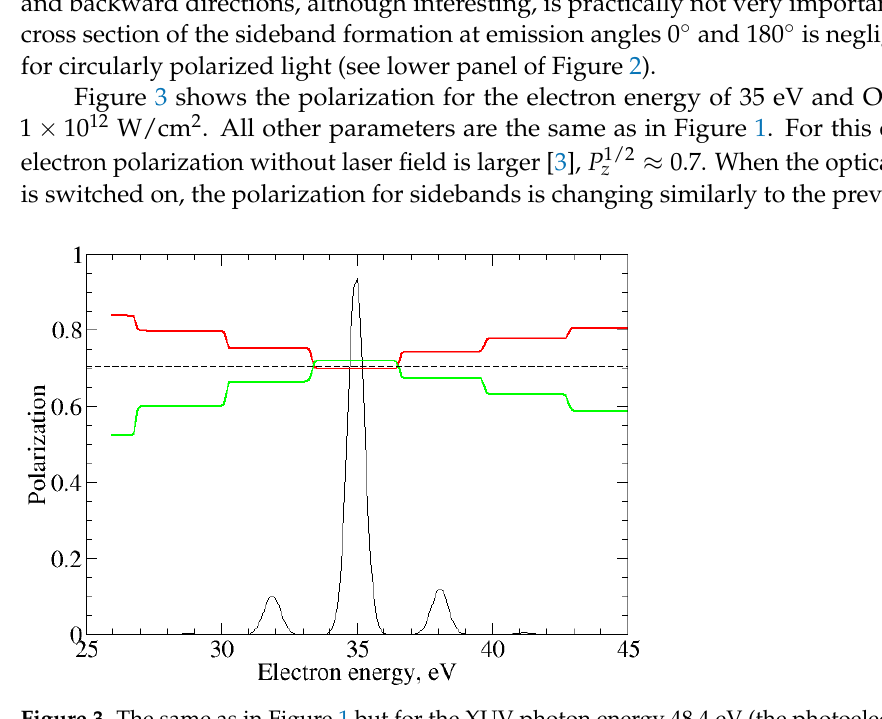
10 12 W/cm 2 . Red line—left-circularly ×